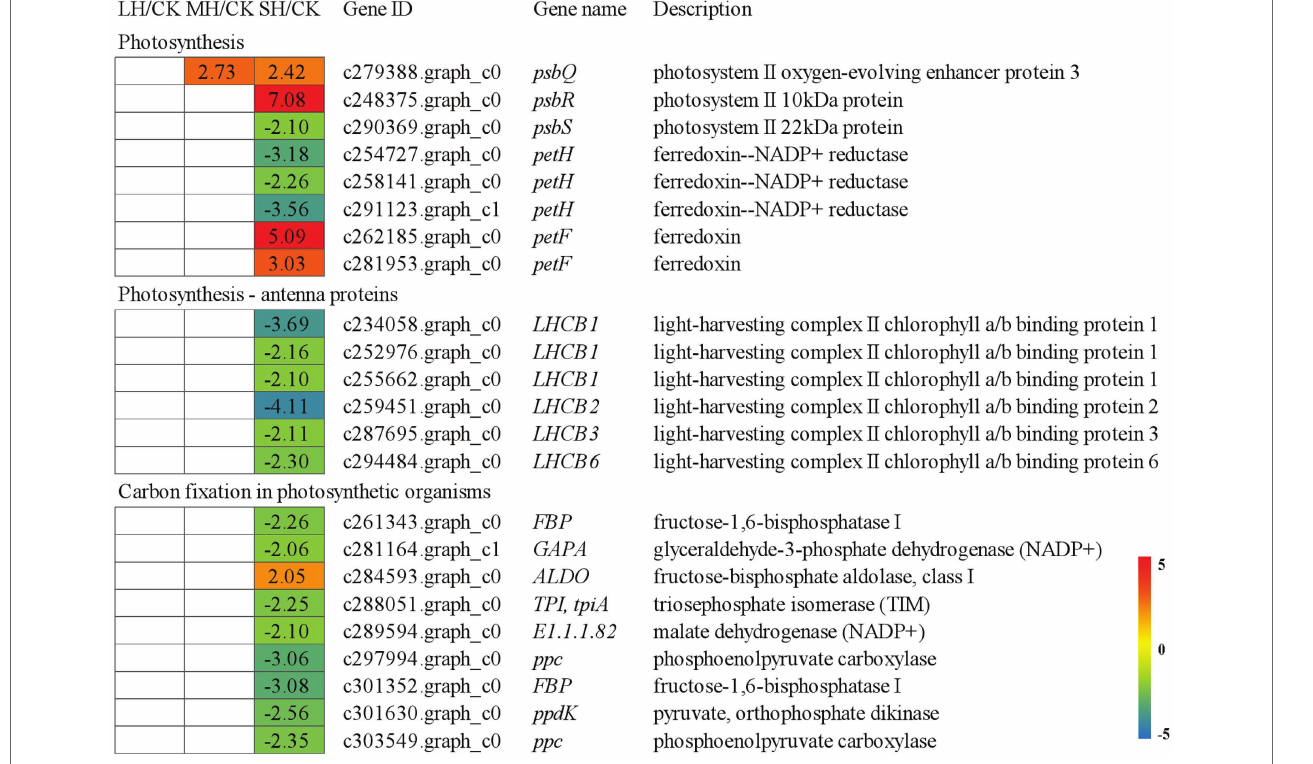
FIGURE 2 | Energy metabolism-related genes identified in the RNA-seq that showed expression changes during temperature treatments. The numbers in the rectangles indicate the log 2 (FC) of the